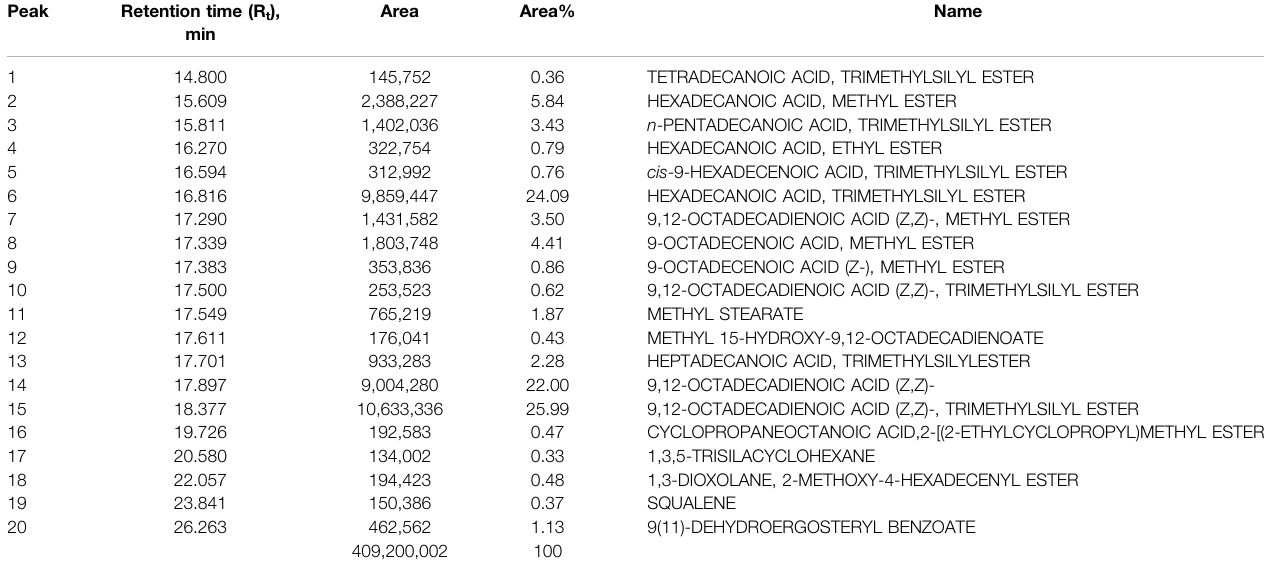
The retention times, peak areas and area percentages are indicated.